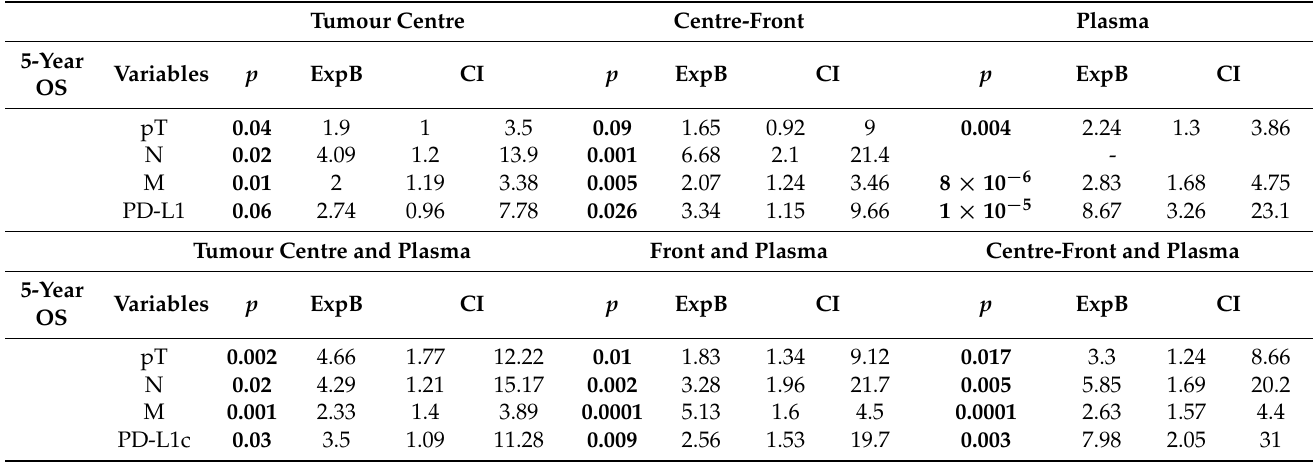
Table 4. Cox Regression model for 5-year overall survival (OS) prediction in CCRCC patients, final step of the Wald Method. Selected pathologic variables for analyses were: Fuhrman grade or G (low vs. high grade), tumor necrosis (no/yes), local